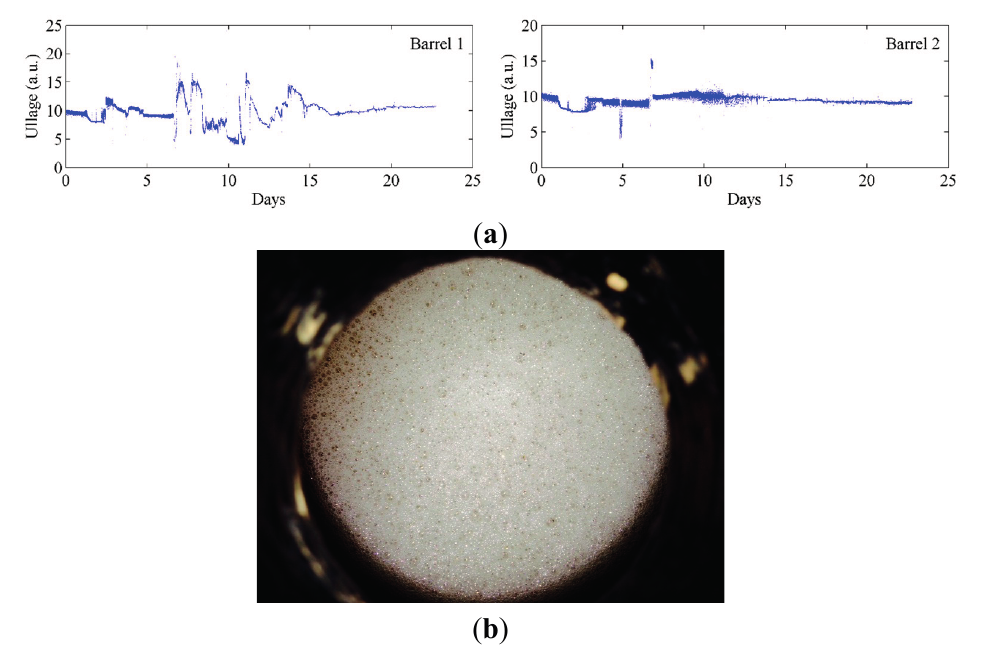
Figure 8. ( a ) Continual monitoring of ullage of two barrels of wine during fermentation; ( b ) the overflowing wine resulting from the excessive bubbling due to carbon dioxide